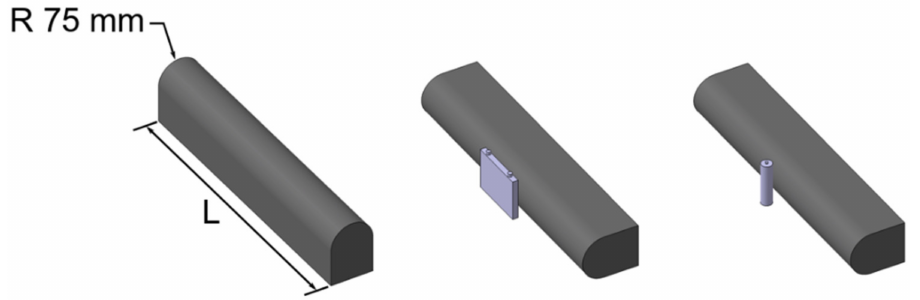
Figure 2. Cell crush board as per GB/T 31485-2015:2015